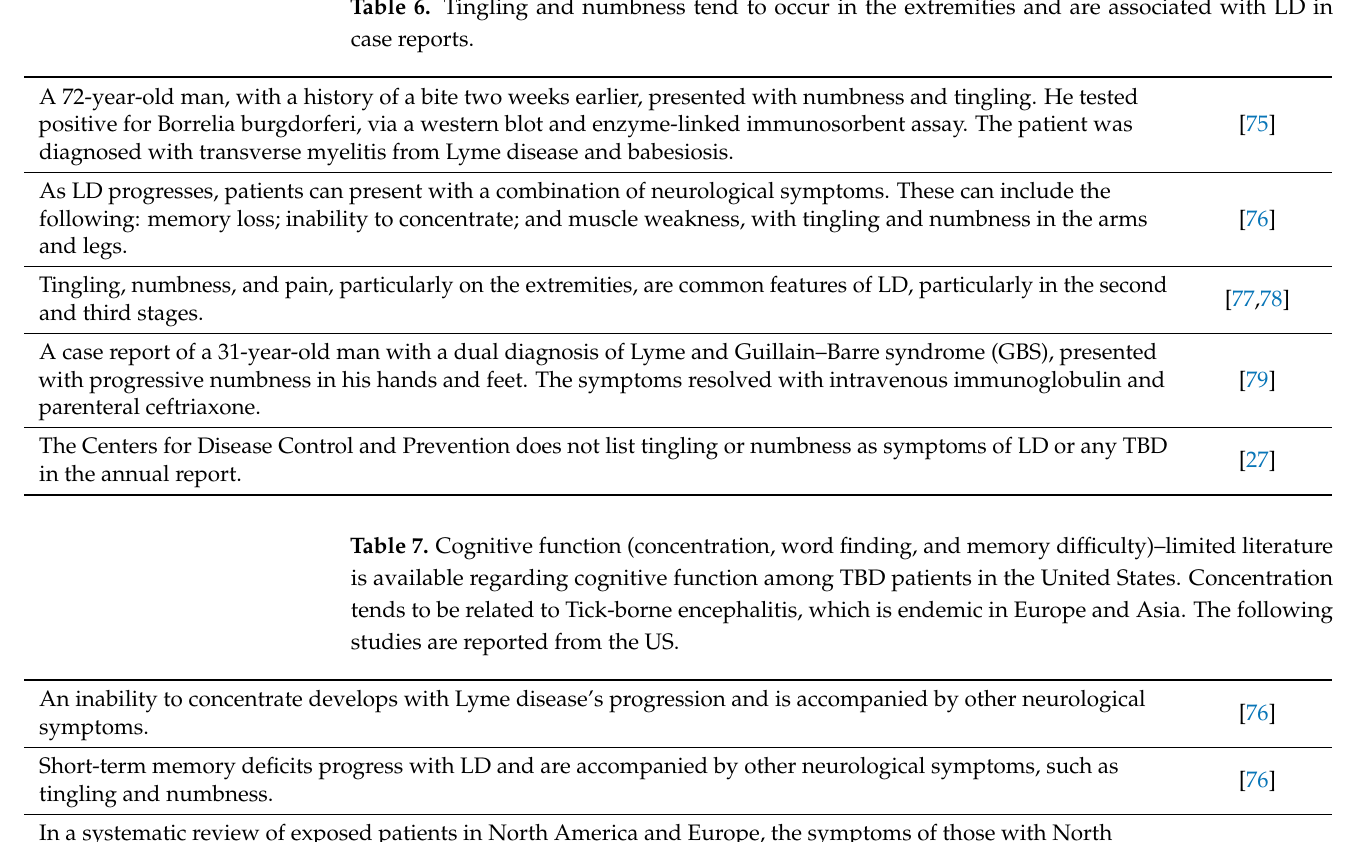
Table 6. Tingling and numbness tend to occur in the extremities and are associated with LD in